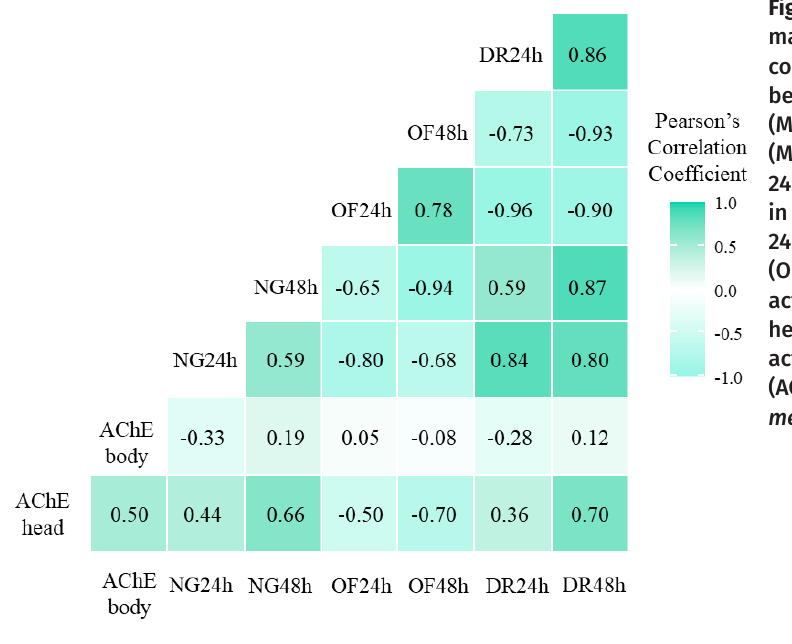
Figure 5. Pearson’s correlation matrix with Pearson’s correlation